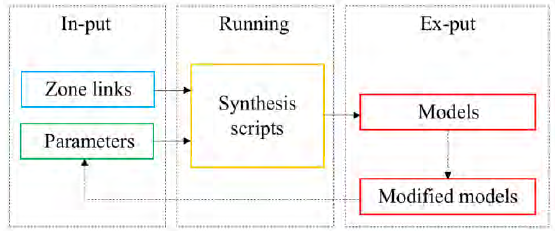
Figure 5. Mode ofparametric modelling system of Form-Based Code